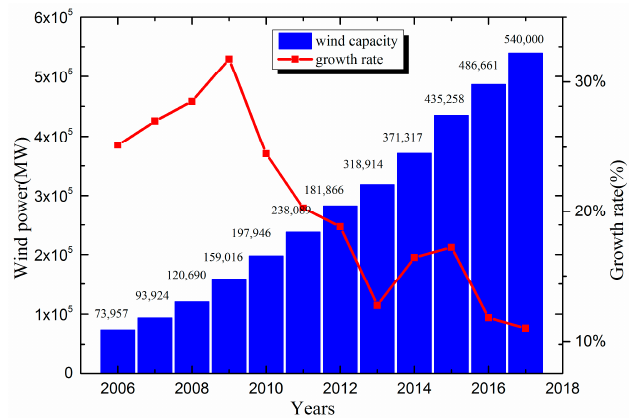
Figure 1. Total installed wind power from 2005 to 2017 worldwide.